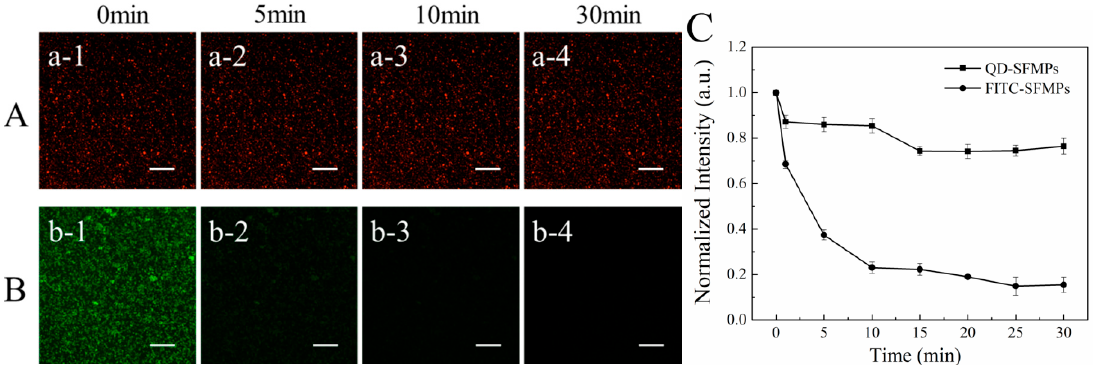
Figure 6. Fluorescence images of ( A ) QD-SFMPs and ( B ) FITC-SFMPs at different time intervals. ( C ) The normalized fluorescence intensity of QD-SFMPs and FITC-SFMPs from 0 min to 30 min, and 1, 2, 3, and 4 denote the irradiation time were 0 min, 5 min, 10 min, and 30 min, respectively. Scale bar: 100 μ m.